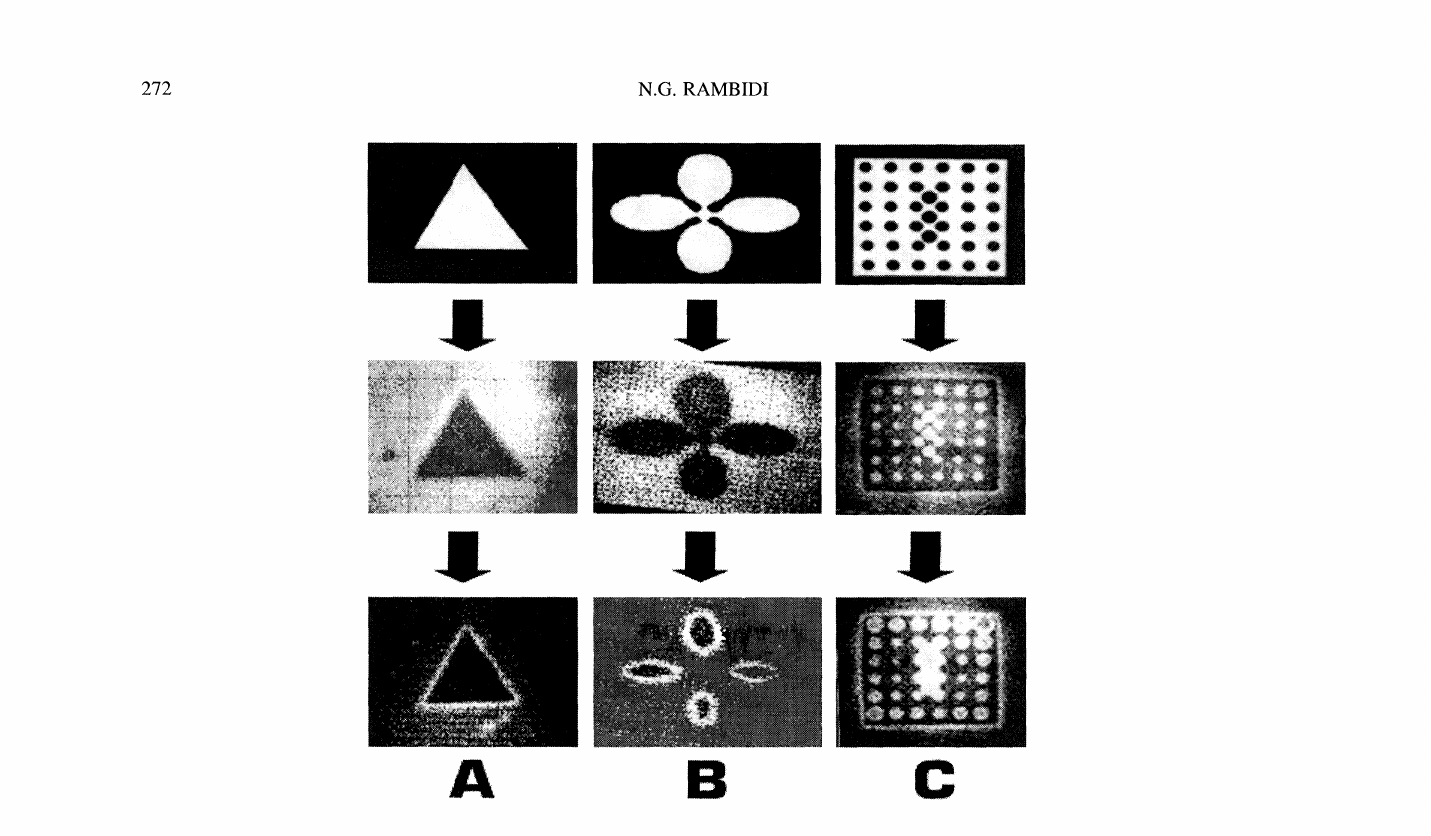
FIGURE 4 Some details of the temporal evolution of images in light-sensitive Belousov-Zhabotinsky type media and results of primitive image processing operations performed by the medium: (A) contour enhancement; (B) segmentation of an image; (C) enhancement of small features. Initial images are in the first row above, results are in the last row at the